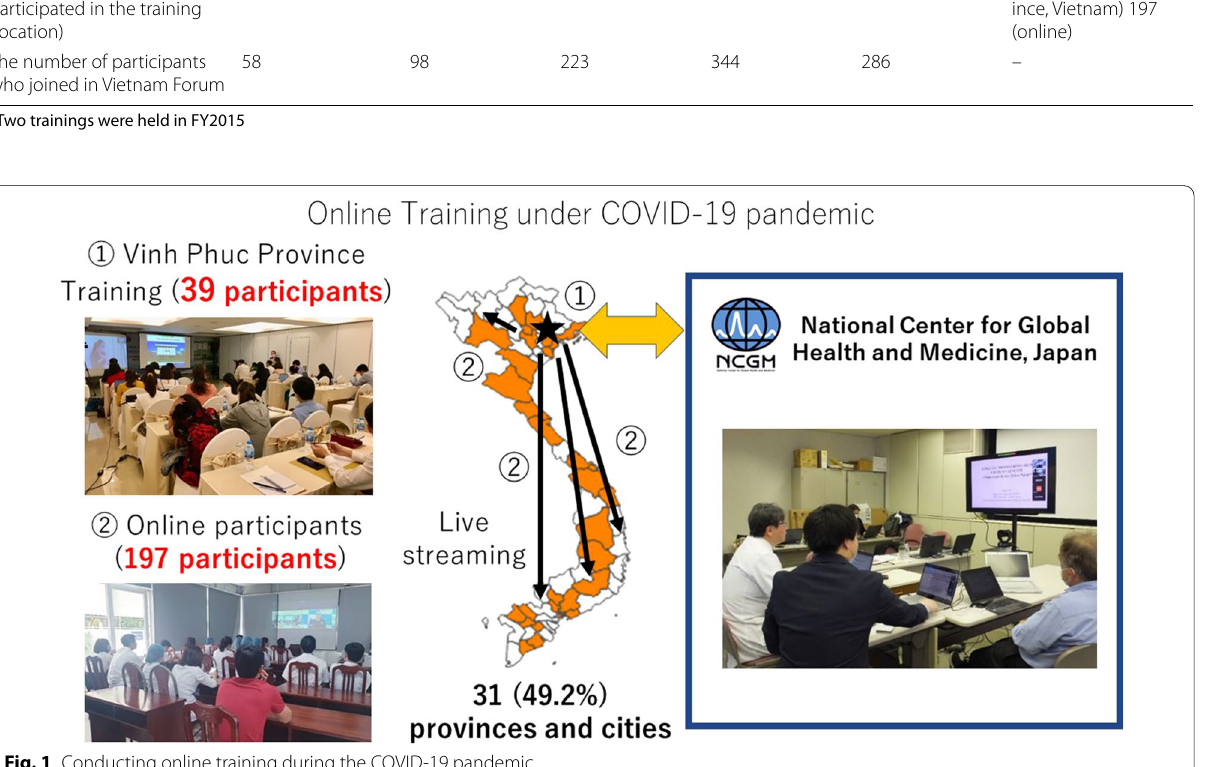
Fig. 1 Conducting online training during the COVID-19